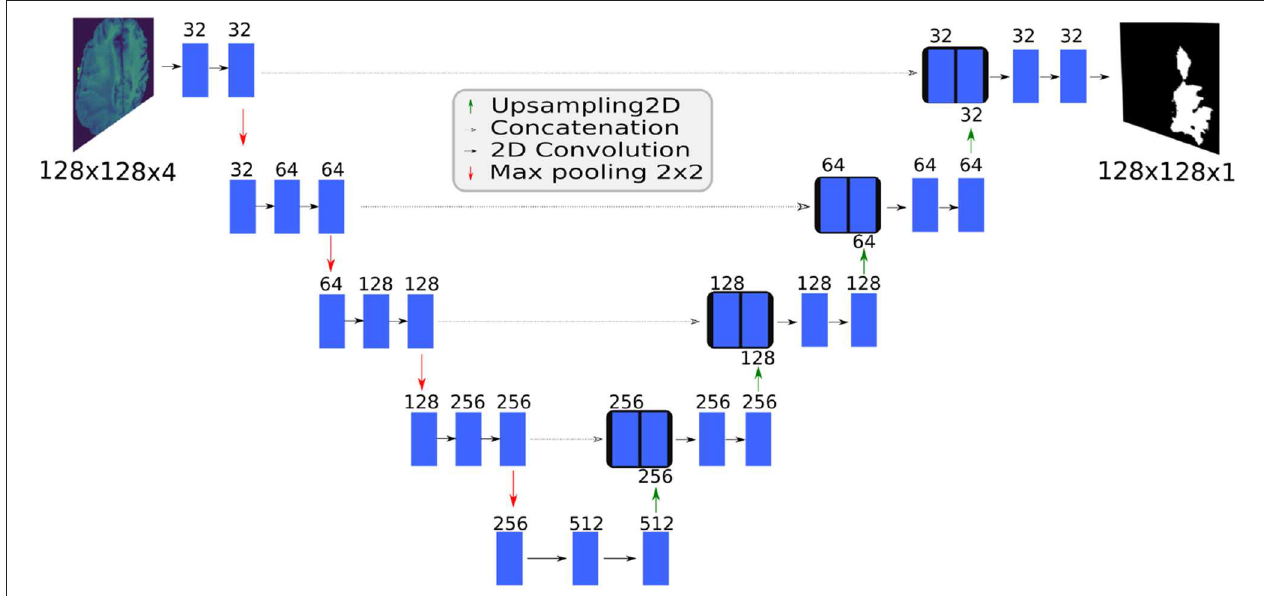
FIGURE 3 | The BraTS 2D U-Net topology. The SpaceNet 2D U-Net and the BraTS 3D U-Net topologies have similar architectures.